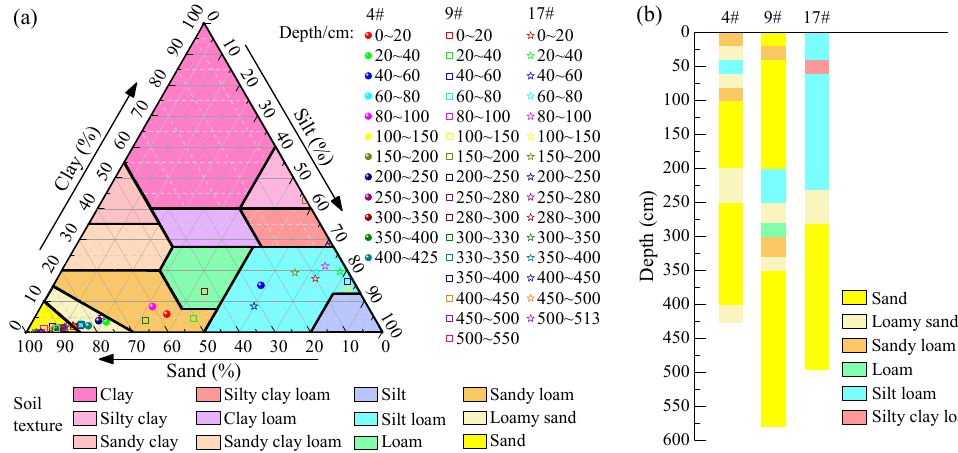
Figure 3. Soil texture diagram: ( a ) triangular diagram of soil texture in depth of test points 4#, 9#, and